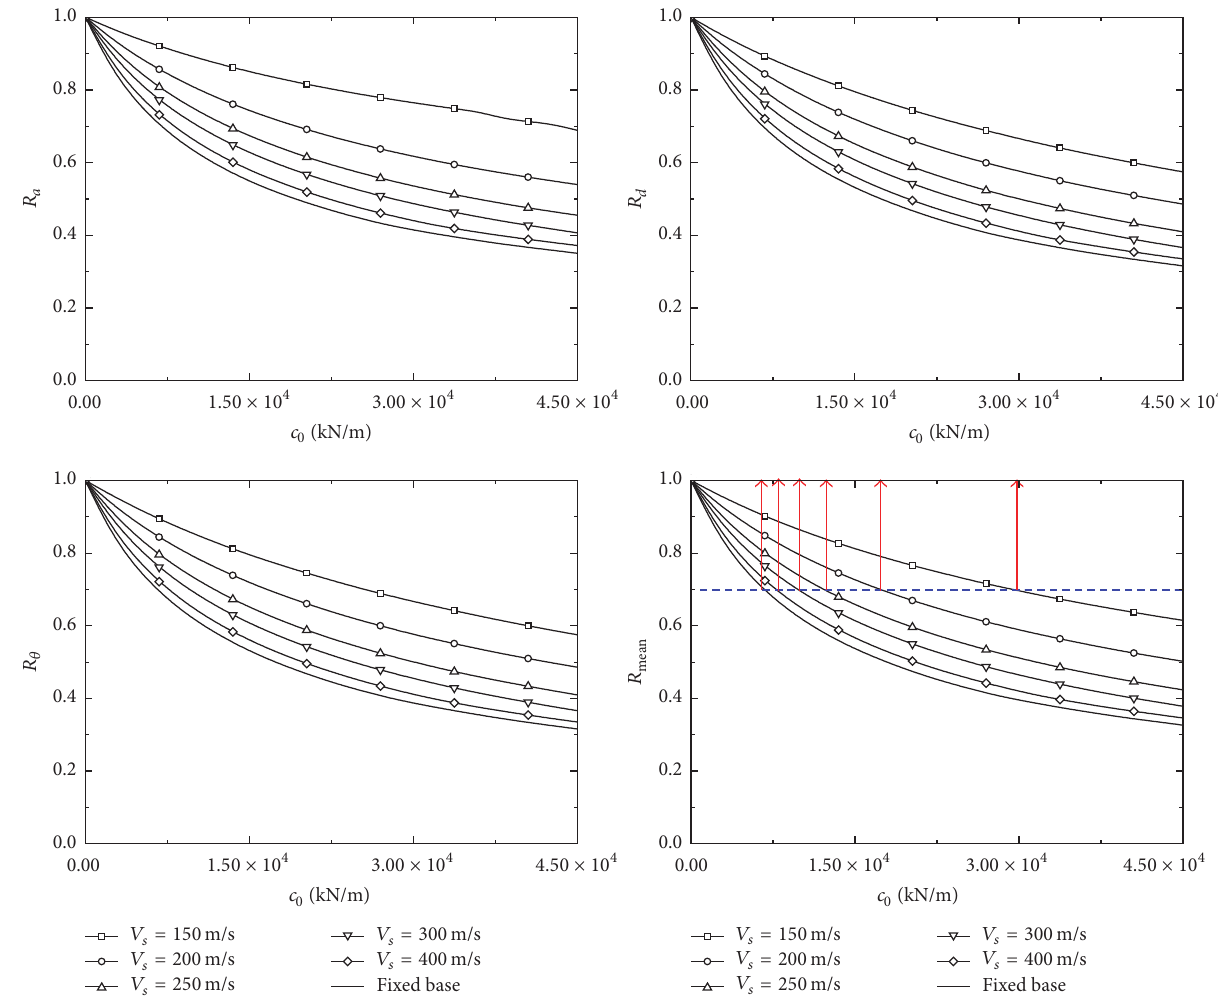
Figure 7: The reduction ratios for 10-story structures ( 𝐸/𝑅 = 1